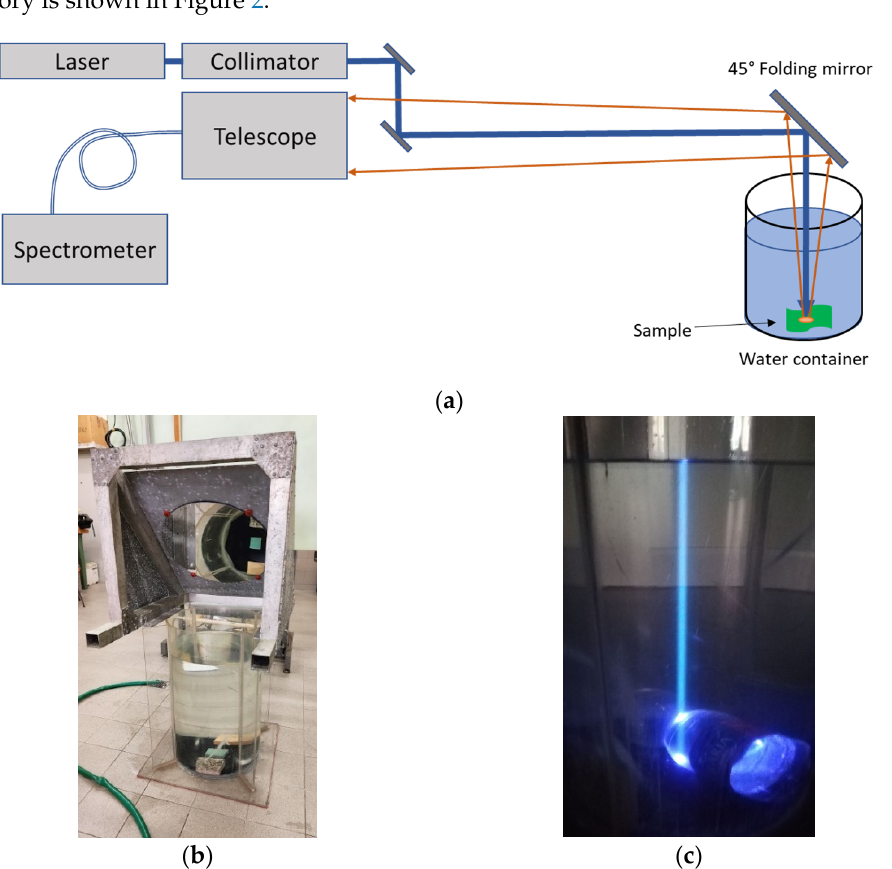
Figure 2. Experimental set-up in the laboratory for the fluorescence LIDAR experiments: ( a ) block diagram of the experimental set-up, ( b ) detail of the 45° mirror and the container filled with water, and ( c ) photo of the laser-induced fluorescence emitted from dissolved organic matter present in the water column and from the plastic bottle when hit by the laser beam.